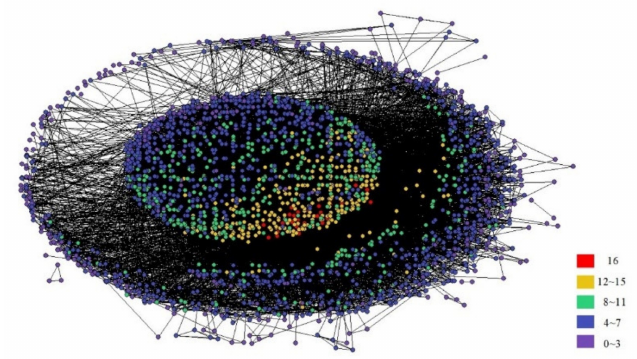
Figure 4. K-cores of the keyword network of the landslide monitoring field.